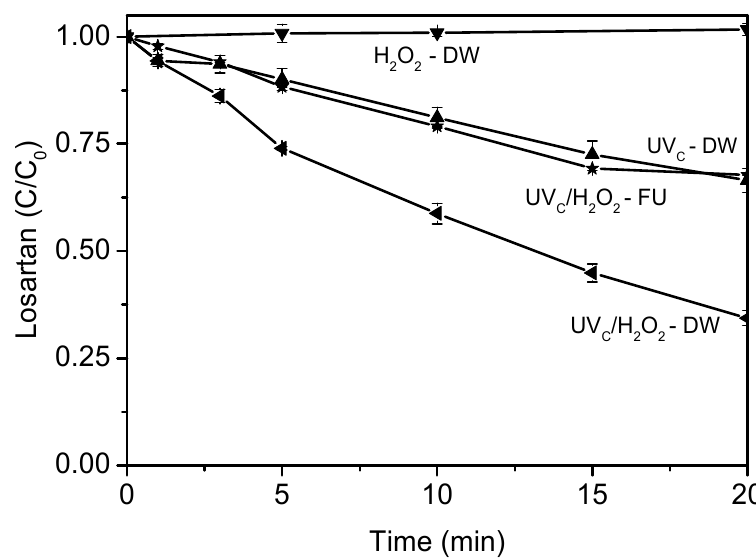
Figure 2. Determination of action routes of the UVC/H 2 O 2 process on losartan degradation in distilled water (DW) and fresh urine (FU). Conditions: [LOS] = 43.38 µM, [H 2 O 2 ] = 500 µM, UVC light: 60 W, pH: 6.1.